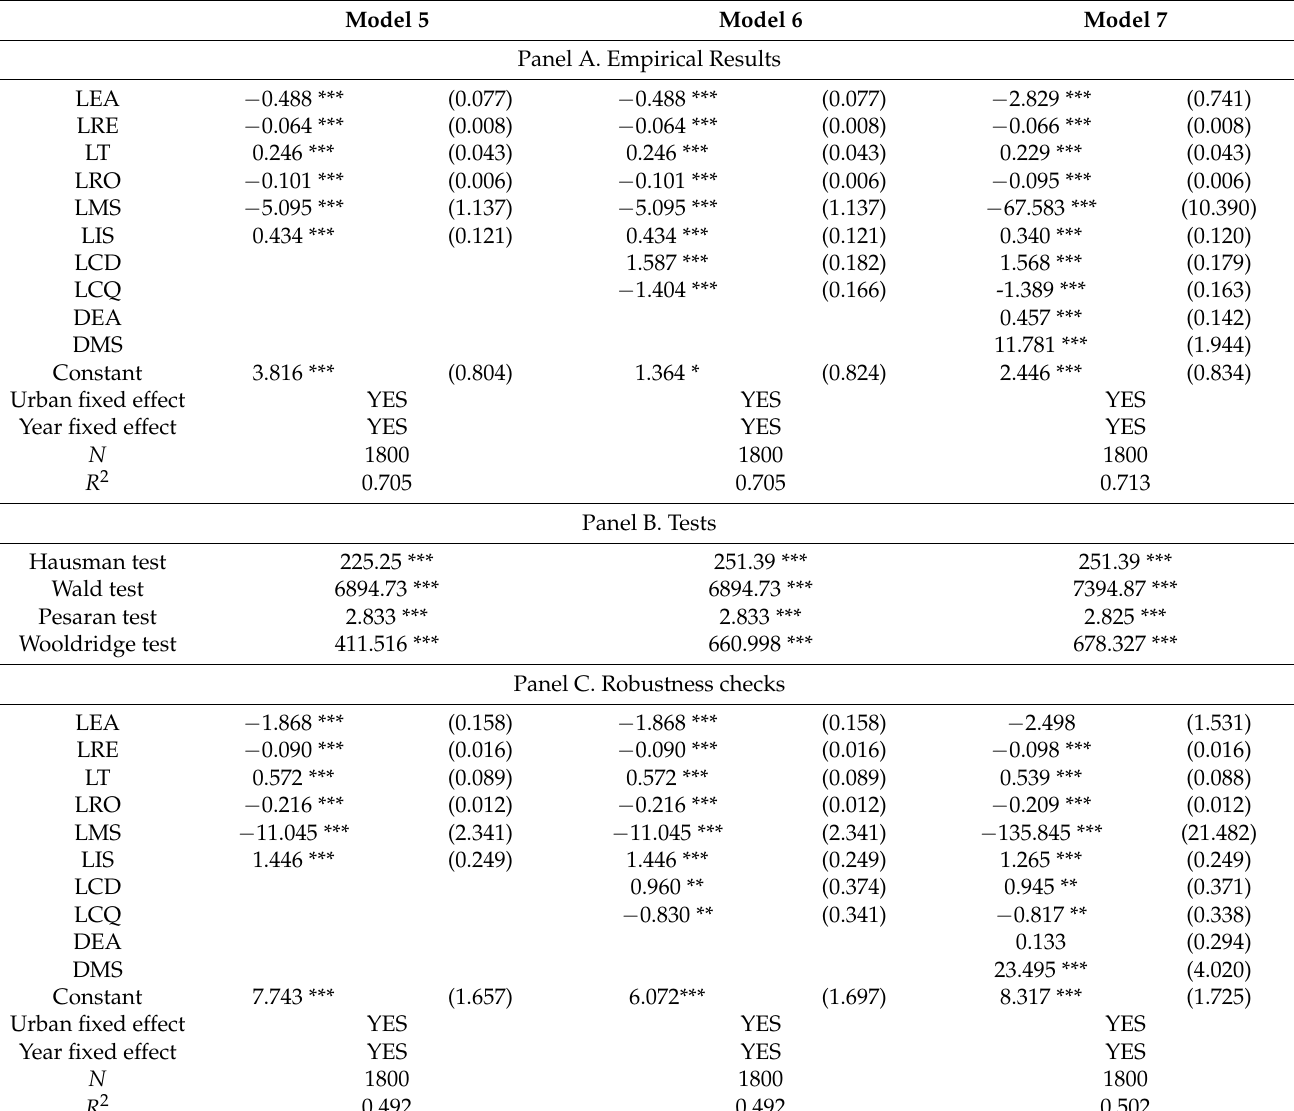
Table 3. Fixed effect of the whole